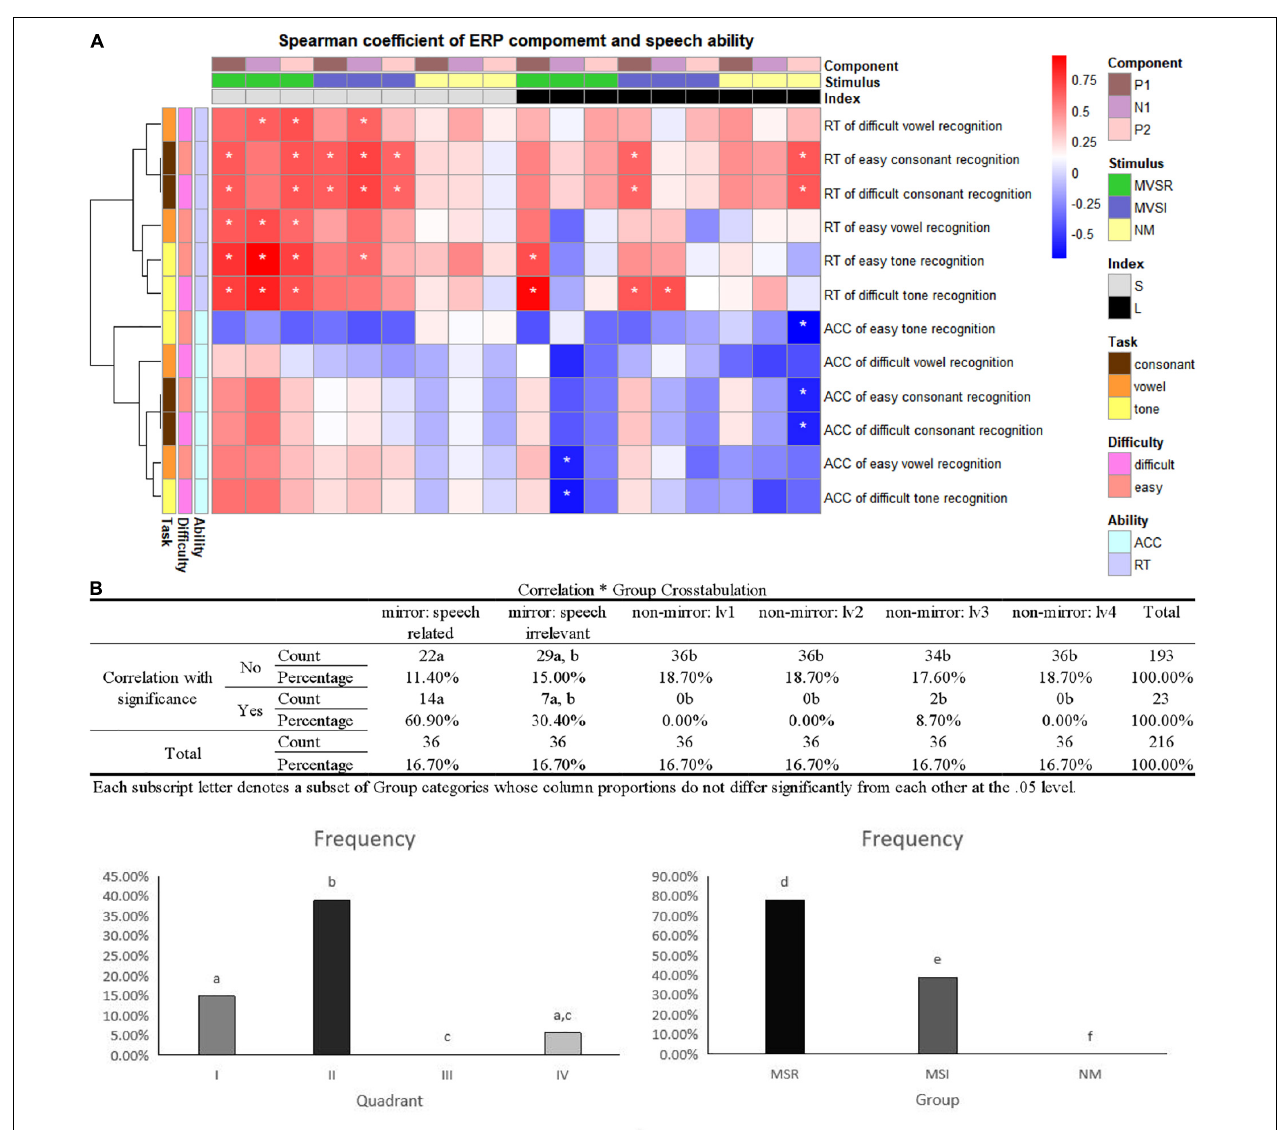
FIGURE 3 | Correlation between ERP component and speech recognition. (A) Heatmaps of Spearman’s correlation coefficient (–1, +1). ACC, accuracy; RT, reaction time; MVSR, mirror and visual speech-related; MVSI, mirror and visual speech-irrelevant; S, stimulus peak; L, latency; ∗ p < 0.05. (B) As the heatmap is a combination of ERP components and speech measures, we tried to find which type of combination (for example: ERP latency–task RT performance vs. ERP peak–task RT performance) resulted in stronger correlations by calculating the percentage of cells with “ ∗ ” in all cells of specific combination. Left: four quadrants as four combinations; right: in II quadrant, MSR/MSI/NM peak–RT performance as three combinations. (I, II, III, IV: quadrant of the heatmap, I: latency–task RT performance, II: peak–task RT performance, III: peak–task ACC performance, IV: latency–task ACC performance. a, b, c, d, e, f: in analysis of crosstab, the same character indicates no significant difference, while a different character indicates a significant